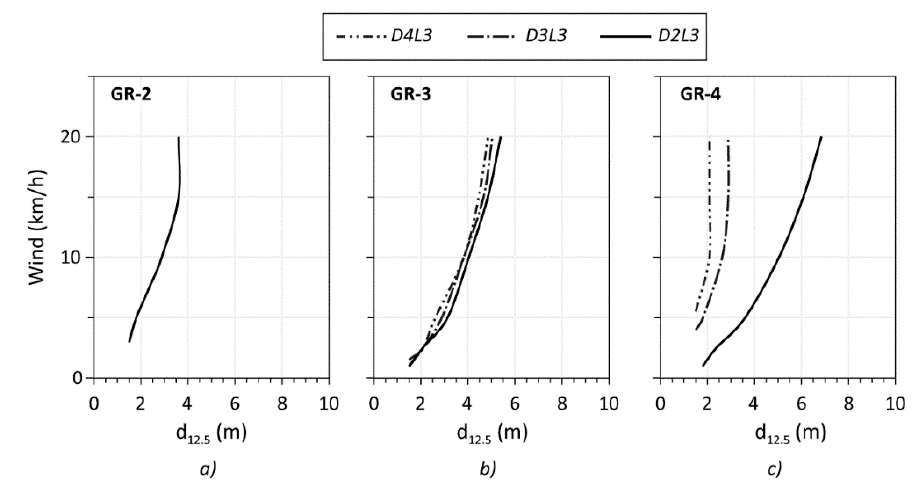
Figure 12. Safe separation distances as a function of wind speed at Low MC of live fuel (L2) and variable MC of dead fuel (D2, D3, D4) for each fuel model of SH category: ( a ) SH-2, ( b ) SH-4, ( c ) SH-8.